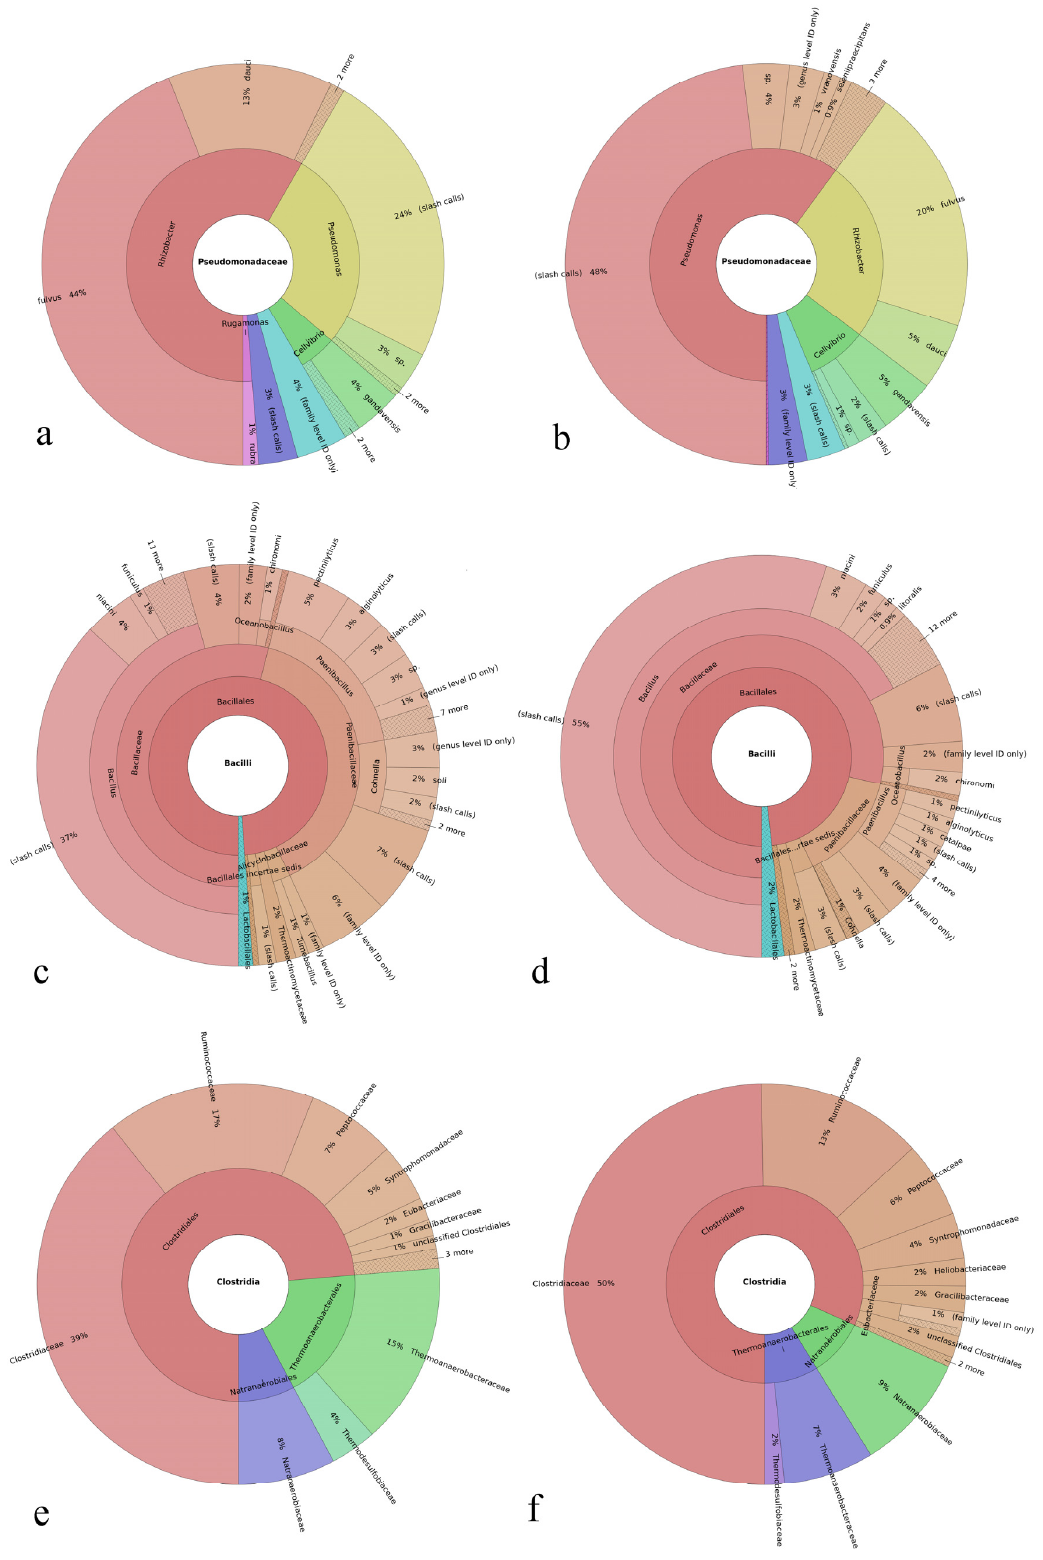
Figure 9. Krona plots focused on the bacterial groups containing some common human pathogens, including Pseudomonadaceae family ( a , b ), Bacilli class ( c , d ) and Clostridia class ( e , f ) for the untreated (a,c,e) and treated (b,d,f) soil samples.